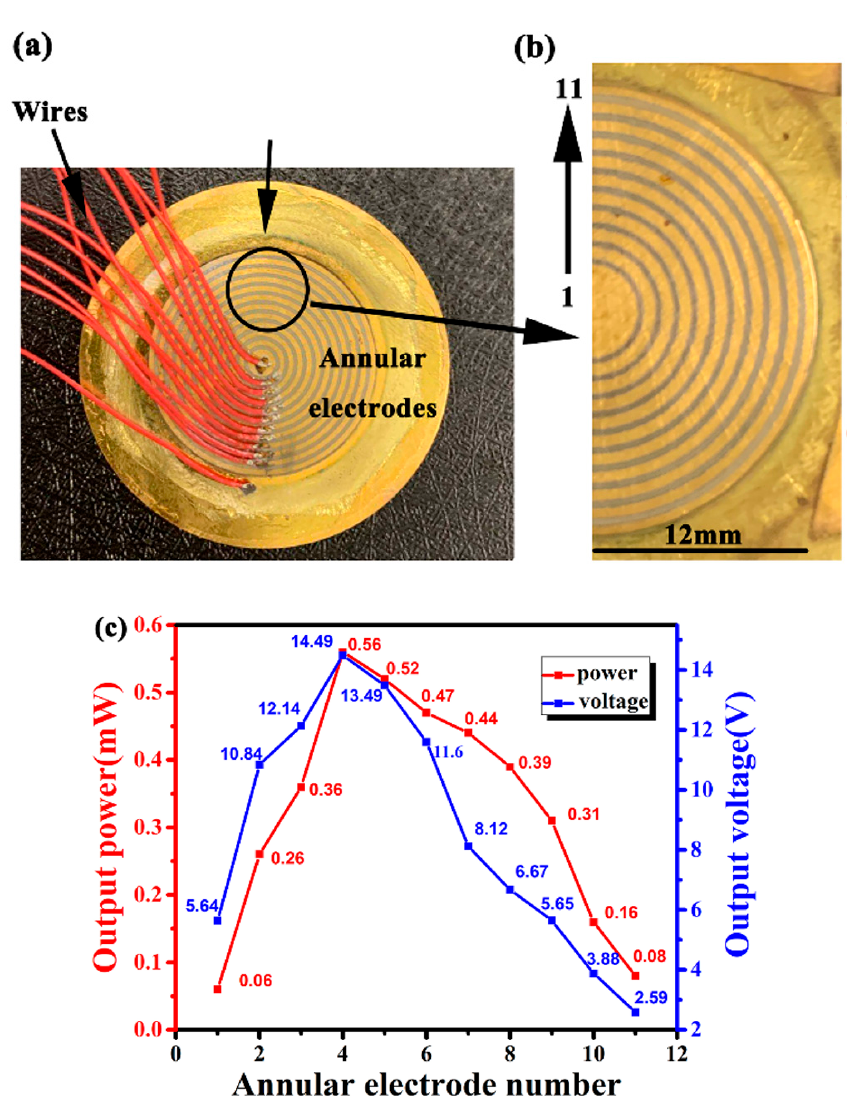
Figure 3. Piezoelectric ceramic disk with annular electrodes ( a ), its partially enlarged details ( b ), and output power and voltage of each electrode ( c ).